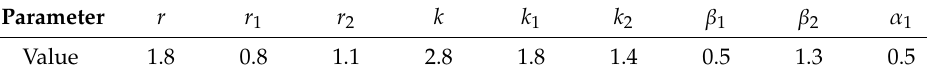
Table 3. Values of parameters.